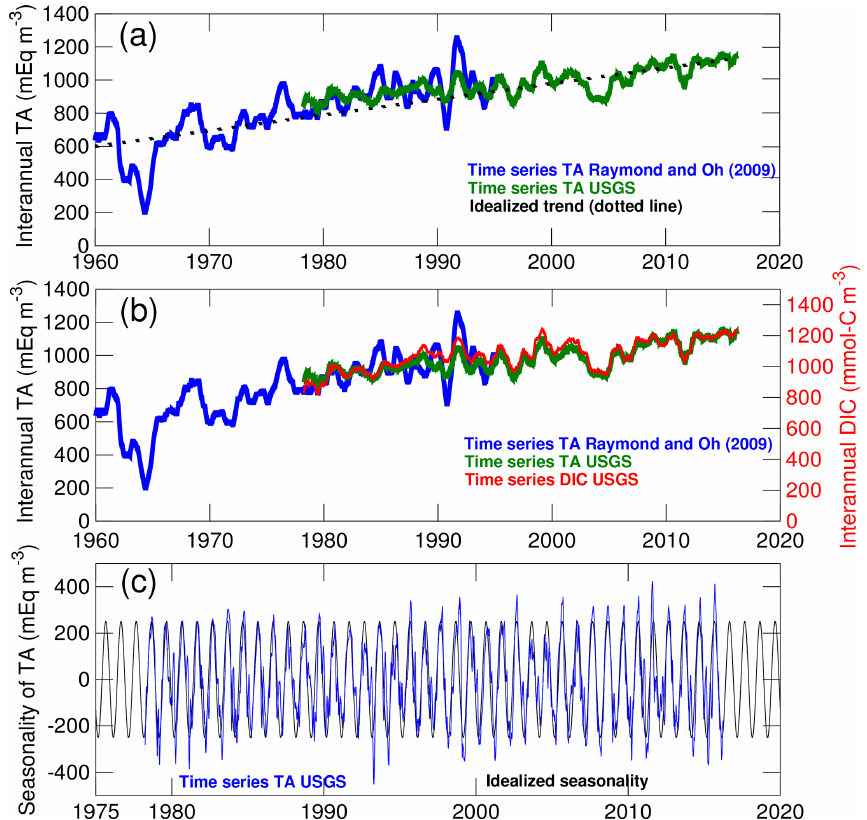
Figure 3. Long-term changes in the concentration of total alkalinity (TA) and dissolved inorganic carbon (DIC) in the Susquehanna River. (a) Comparison between TA time series from two locations in the river (see Methods section). The interannual variability of the time series is emphasized with a 1-year moving average. The dotted line represents the idealized linear trend used in the control experiment. (b) Comparison between time series of TA and DIC. (c) Comparison between the seasonality of TA and the idealized seasonal cycle used in model